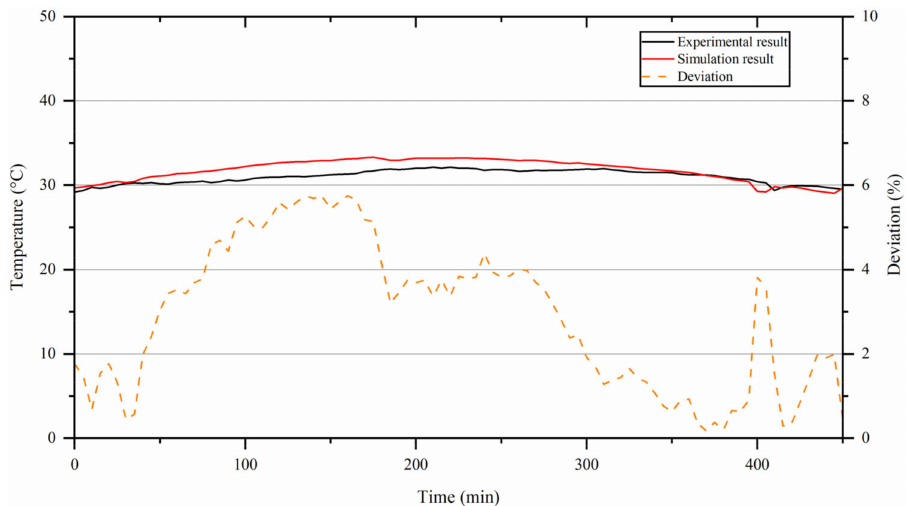
Figure 7. Comparison between experimental and simulation output temperature of PV/T.